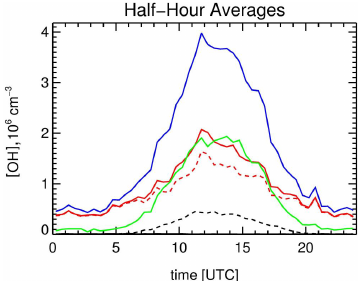
Figure 6. Mean half-hour values measured in marine air during the time period 2010–2011 calculated from the OH mode raw signal at m/z 99 (blue line), total background mode raw signal at m/z 99 (red line), OH mode signal minus background mode signal (green line: net signal counts corresponding to the ambient OH concentra- tion), signal counts at m/z 99 due to 34 S mass fraction of ambient H 2 SO 4 (black dashed line: signal( m/z 97) · 0.044), and OH mode background signal with 34 S fraction of ambient H 2 SO 4 subtracted (red dashed